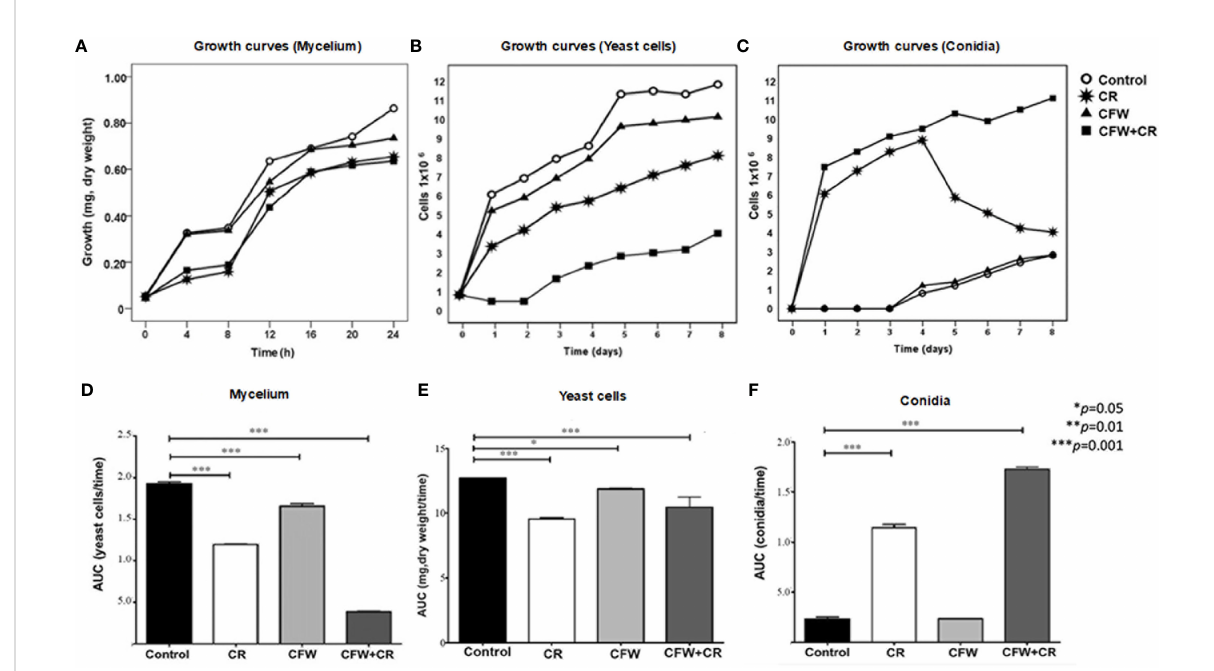
FIGURE 5 In fl uence of CR and CFW on growth of S. globosa . In (A) growth of mycelial cells was determined after the indicated times of incubation in the absence and presence of 150 m M CR or 1% CFW either alone or in combination. Growth of the yeast morphotype was assessed after the indicated times by counting either the yeast cells (B) or CN (E) . The statistics analyses presented in (B, D, F) were calculated from the values obtained from the area under the curve (AUC) for each growth condition. Reproduced from Ortiz-Ramirez et al., 2021, with permission